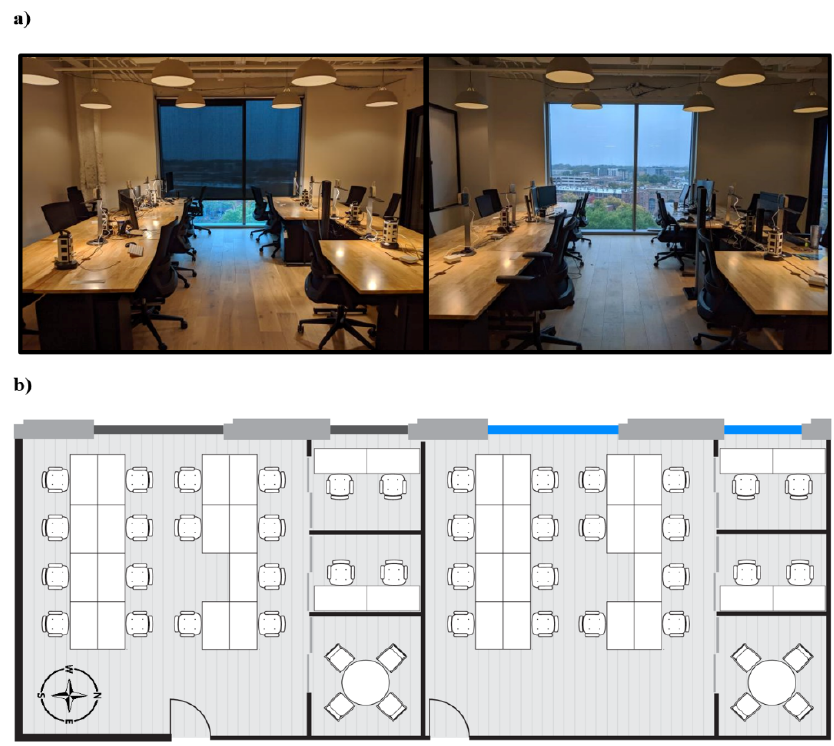
Figure 1. ( a ) Photos and ( b ) floorplans of the two office environments.